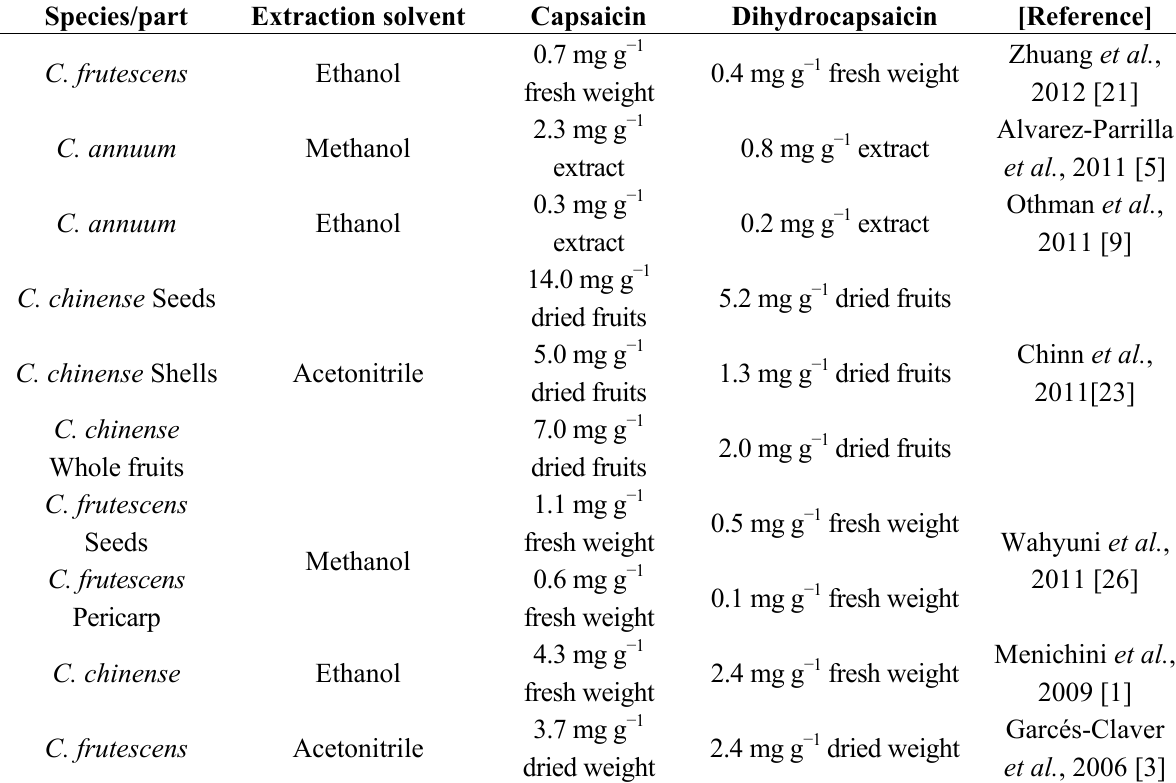
Table 2. Capsaicin and dihydrocapsaicin content in various species of Capsicum